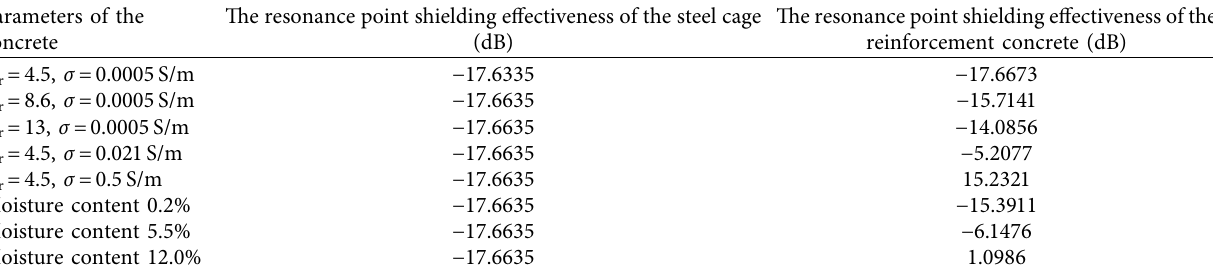
Table 3: Comparison of the resonance point shielding efectiveness under diferent concrete electromagnetic parameters. Parameters of the Te resonance point shielding efectiveness of the steel concrete